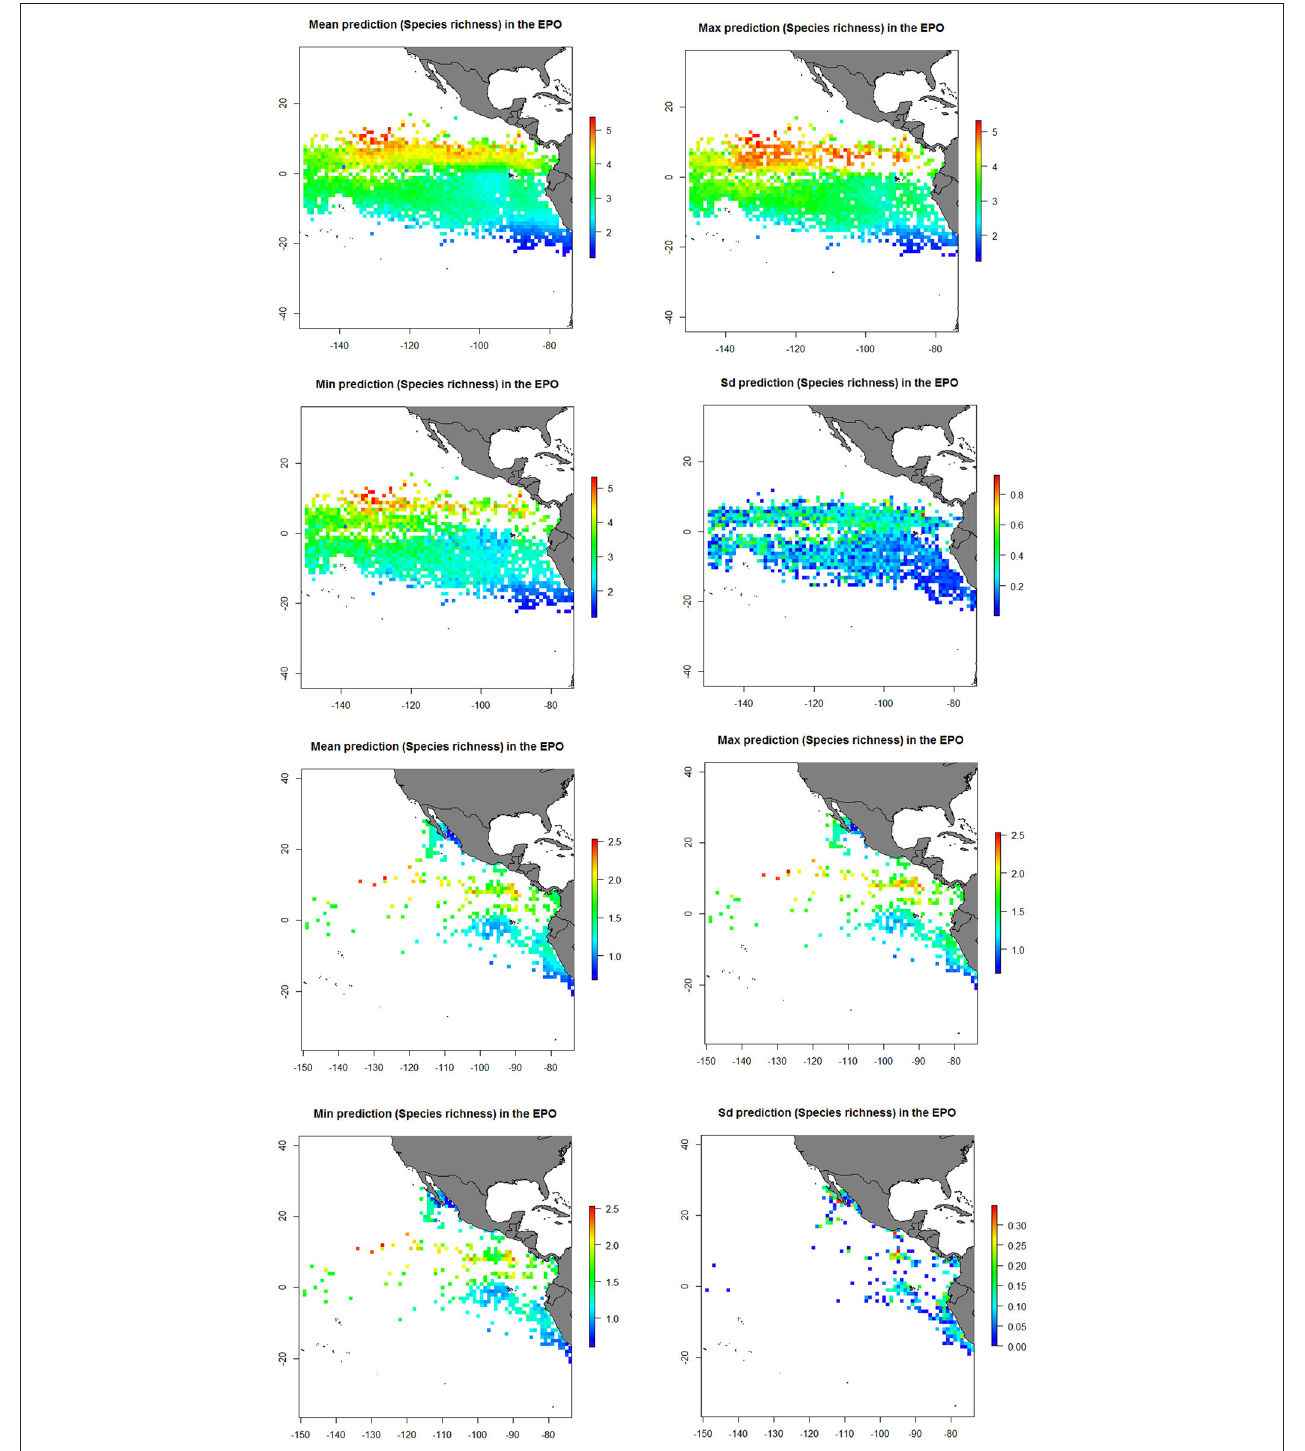
FIGURE 7 | Predicted diversity (Species richness index) of the bycatch assemblages by type of set in the eastern Pacific Ocean (EPO) from the generalized additive model (GAM). Mean diversity; Maximum diversity; Minimum diversity and Standard deviation of diversity for FAD (upper four) and School sets (bottom four).